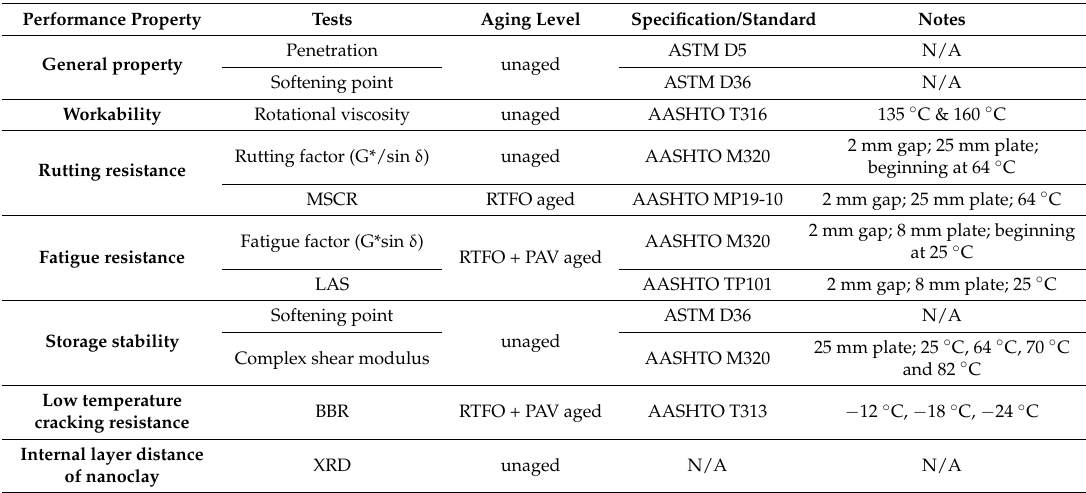
Table 3. Details of laboratory tests.